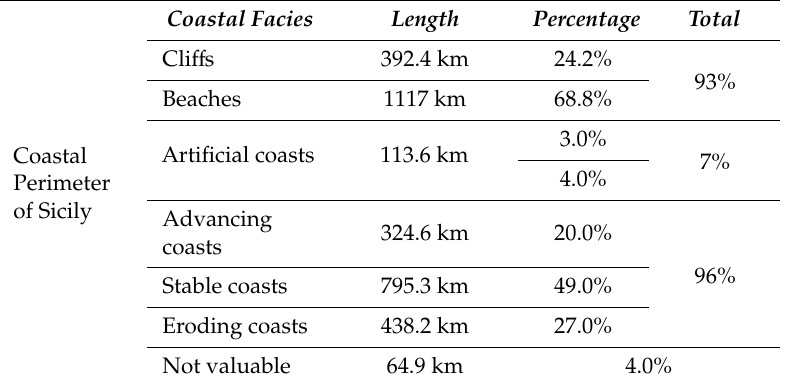
Table 1. Variability of coastal facies both in percentage and kilometers (including minor